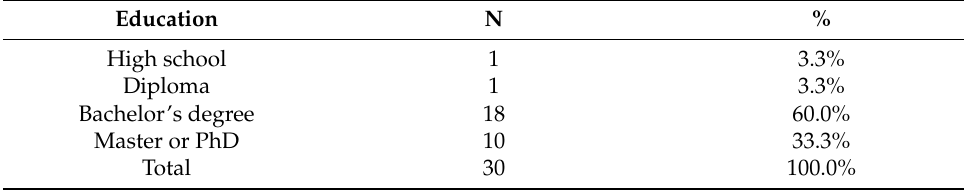
Table 5. Respondents’ last education.